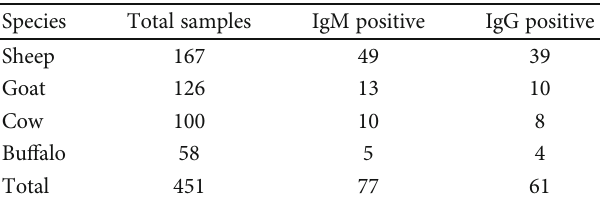
Figure 1: Di ff erent study areas in the Khyber Pakhtunkhwa Province of Pakistan. Table 1: Total number of sera examined along with antibody positivity from di ff erent species in the study